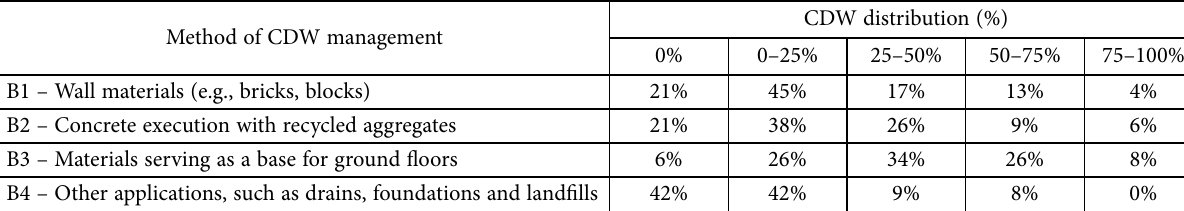
Table 6. Distribution of CDW reuse on construction site ( n =